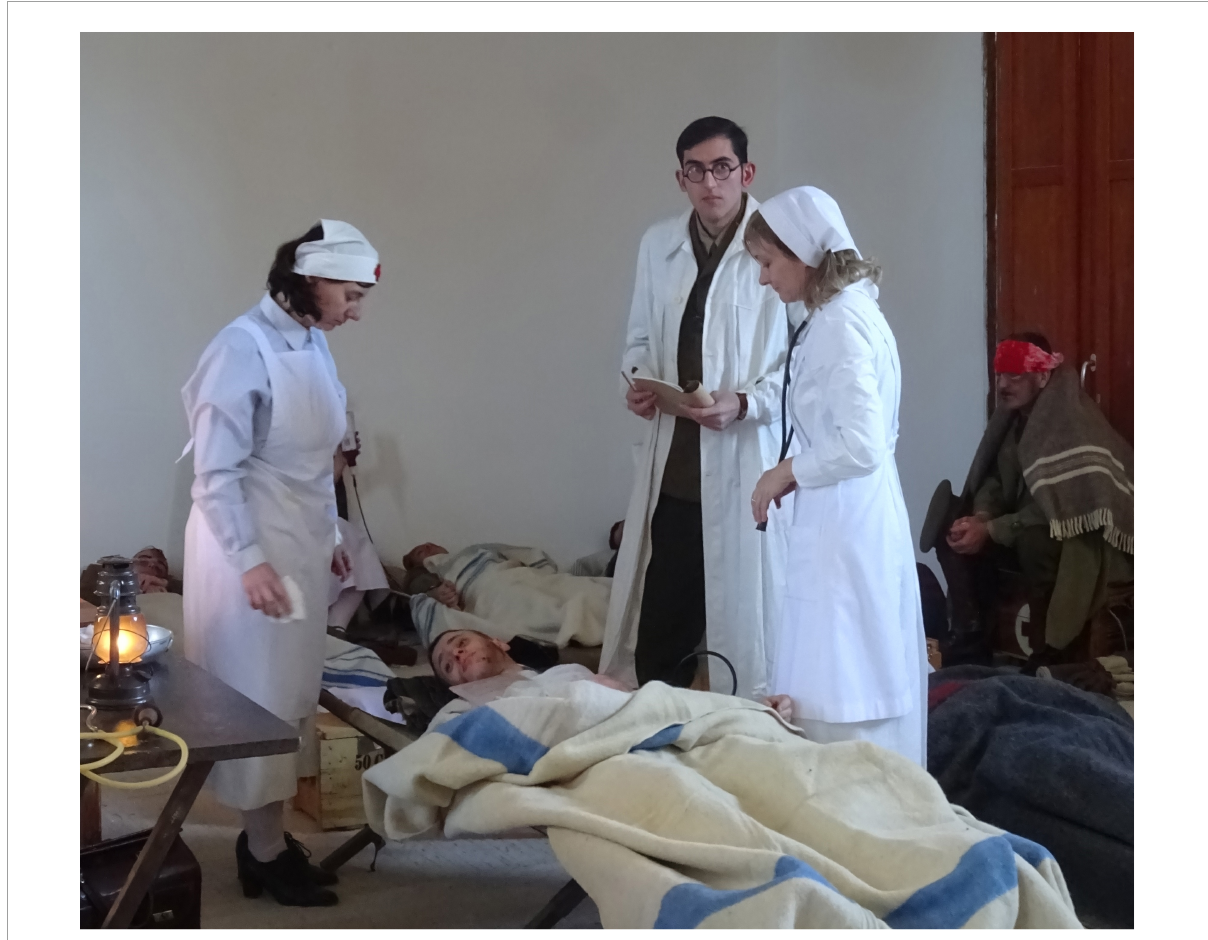
FIGURE2 Students of master’s studies in cultural and heritage management at the University of Barcelona in a film based on historical recreation for a hospital interpretation center during the Battle of the Ebro, during the Spanish Civil War. Recording set in the Molar hospital. A graduate nurse, members of a recreation group, and several students from the University of Barcelona take part together.